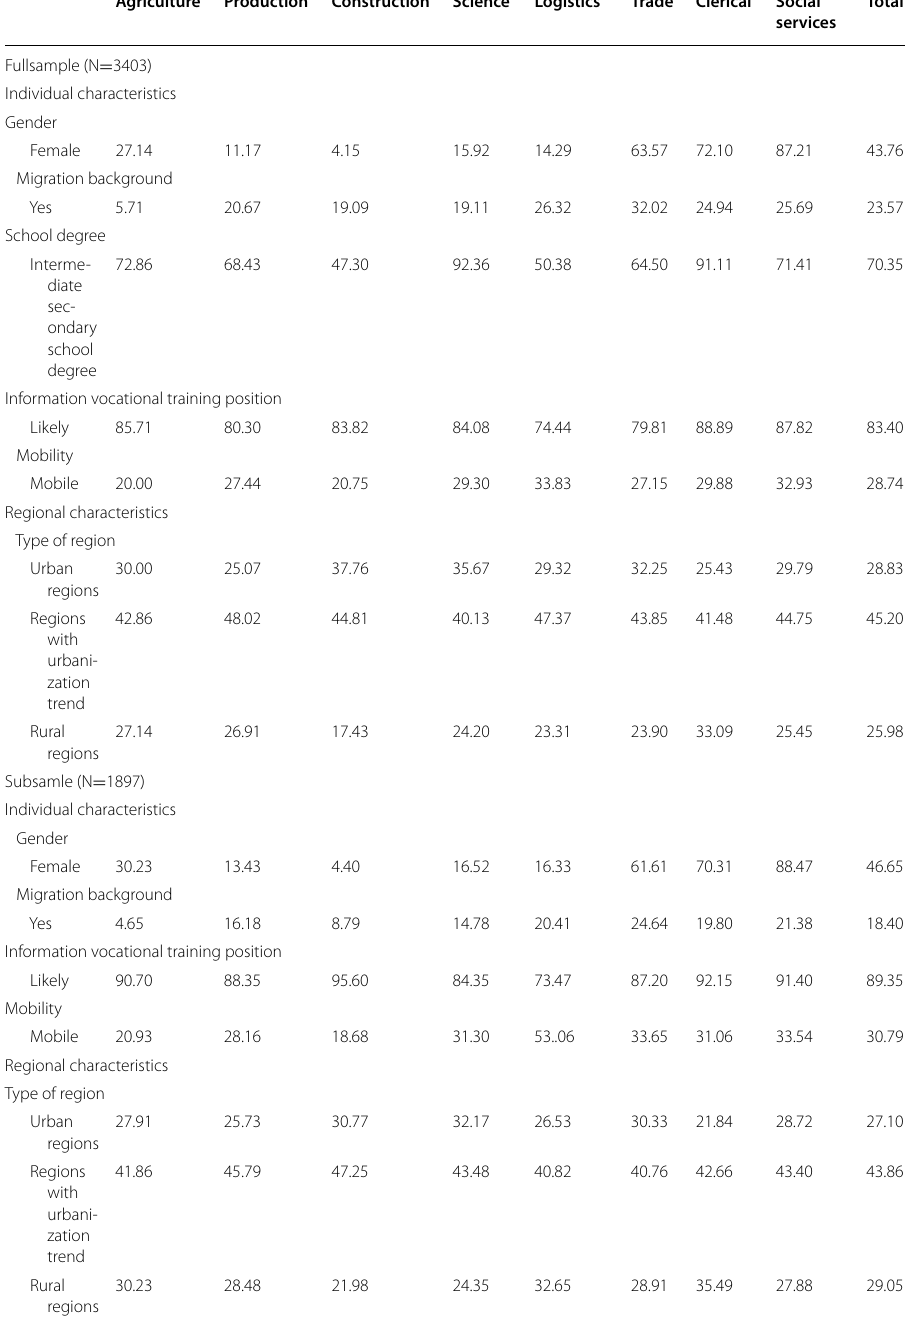
Table 7 Descriptive statistics of independent categorical variables for each occupational category in